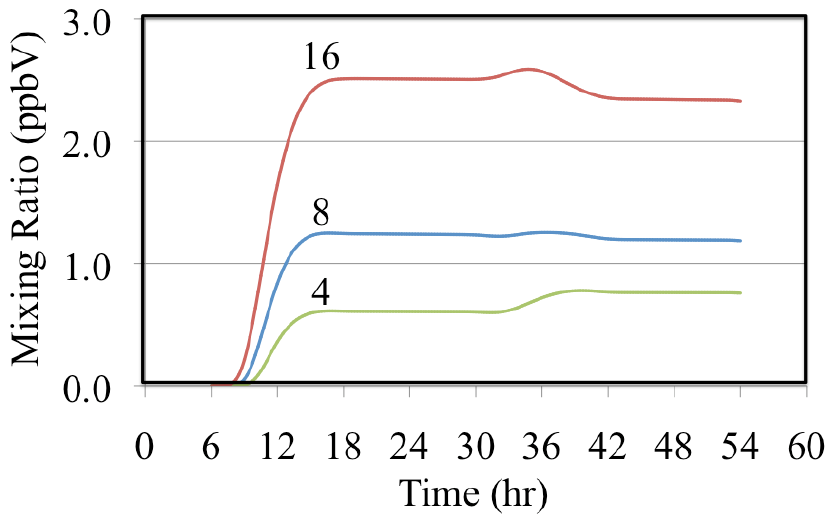
Figure 13. Hydrogen peroxide mixing ratios are shown for the ethene cases. The number indicates the initial VOC/NO ratio in x